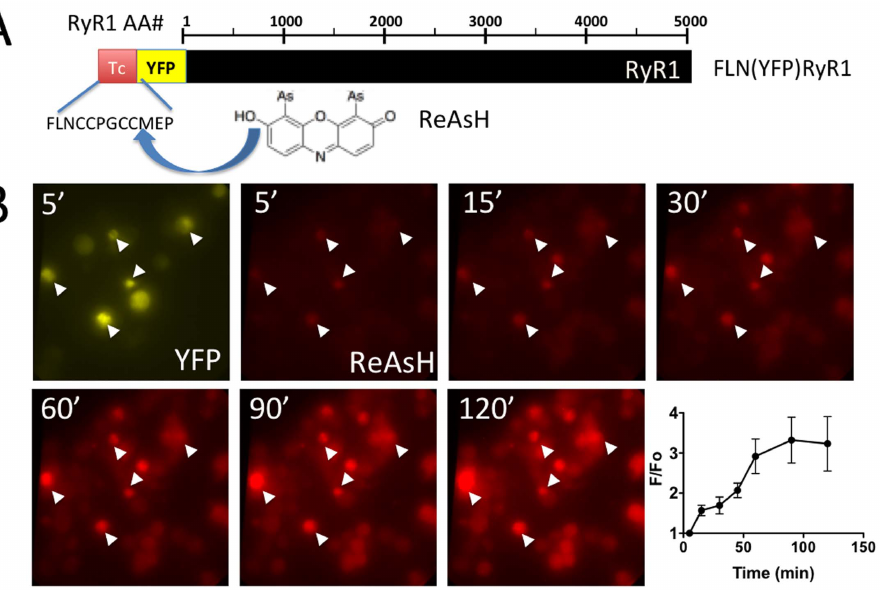
Figure 1. ReAsH labeling of Tc-tagged RyR1. (A) ReAsH binding to an optimized Tc tag attached to a YFP-RyR1 fusion protein (FLN(YFP)RyR1) was assessed via determination of YFP/ReAsH colocalization in intact cells. Black bar indicates RyR1 primary sequence. (B) ReAsH labeling timecourse of HEK-293T cells expressing FLN(YFP)RyR1. YFP (upper left panel) and ReAsH fluorescence (subsequent panels) was recorded at the indicated timepoints after addition of ReAsH. Arrowheads indicate same cells in all panels. ReAsH labeling timecourse is also presented as aggregate ReAsH fluorescence at each timepoint normalized to initial fluorescence 5 min after ReAsH addition (F/F 0 ) (lower right).